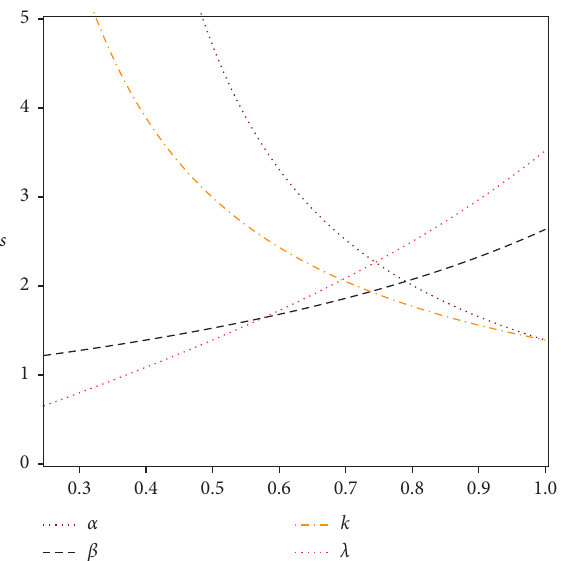
Figure 1: Influence of relevant parameters on the cooperation effort degrees.